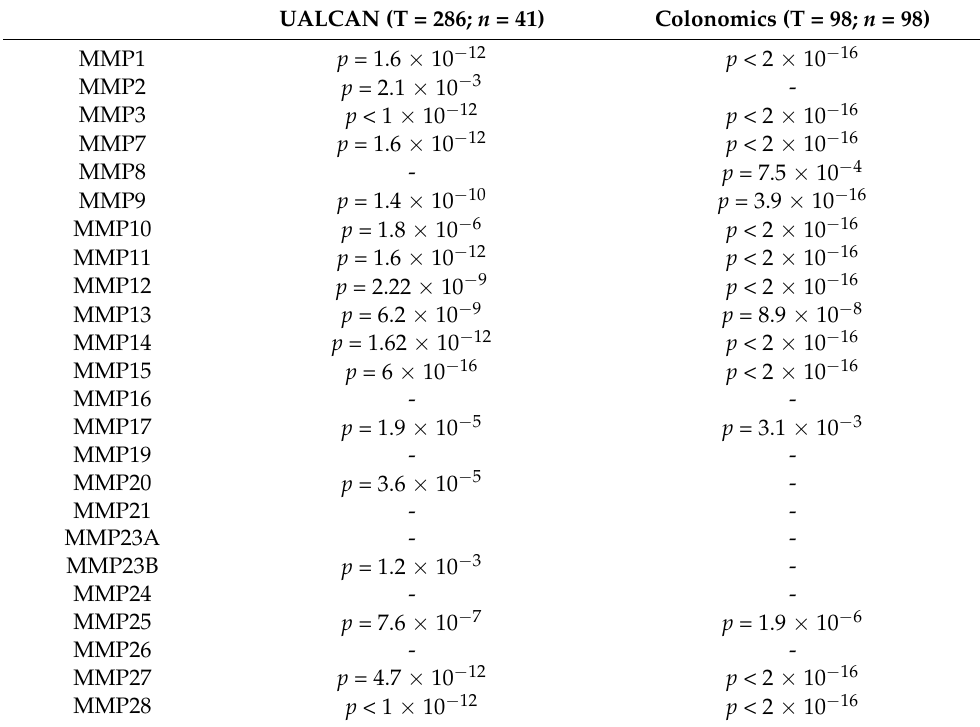
Table 2. Differential expression analysis of MMP members between normal and colon cancer tissues using UALCAN and Colonomics. Databases were searched for MMP expression between normal and tumoral tissues and differences were considered significant when p < 0.01. The MMP members significantly upregulated in tumors compared to normal tissues are: MMP1, MMP3, MMP7, and MMP9-14. The MMP members significantly downregulated in tumors compared to normal tissues are MMP15, MMP17, MMP25, MMP27, and